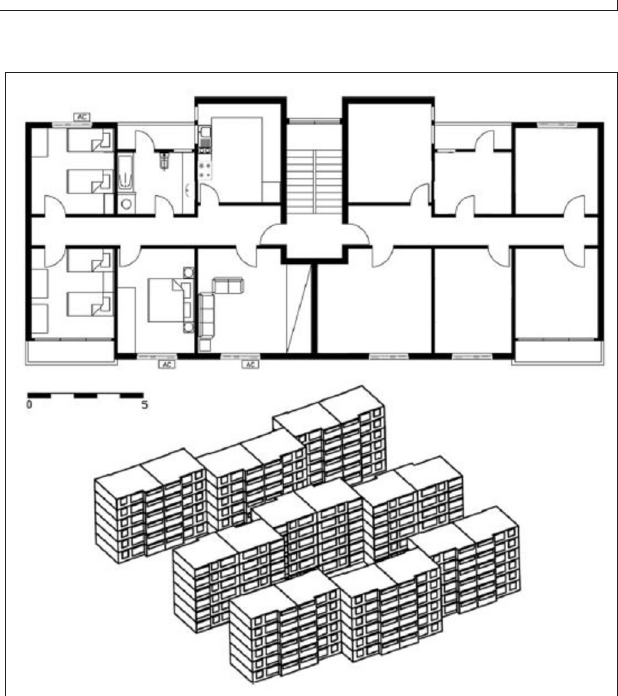
FIGURE 1 | Methodology workflow.